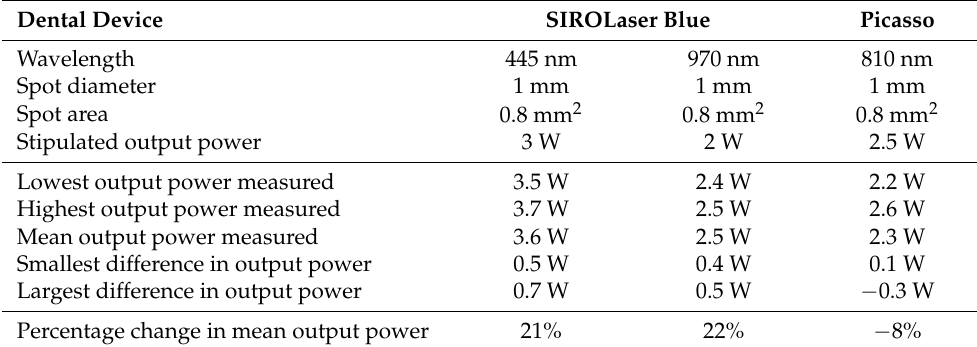
Table 1. Parameters stipulated and actual power of laser devices in continuous-wave mode. Dental Device